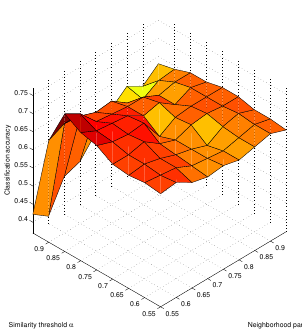
Figure 2. Classification accuracy for the pima dataset.